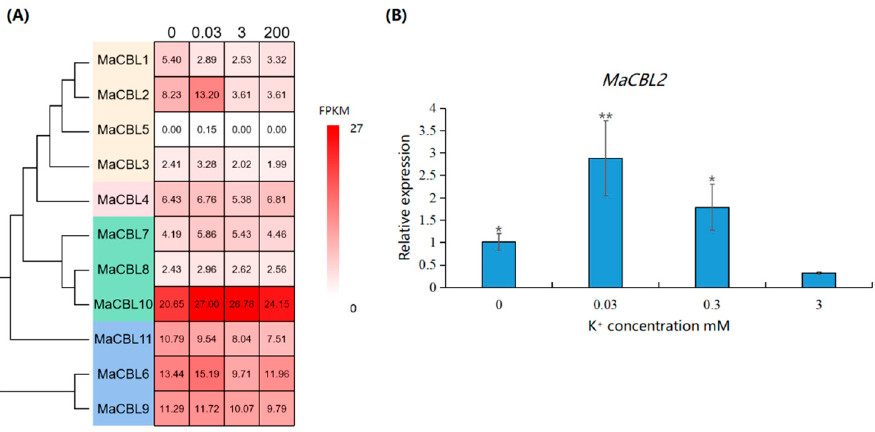
Figure 4. Expression tendency analysis of the MaCBL genes in bananas under potassium stress. ( A ) The expression pattern of MaCBLs in bananas under different potassium-stress levels, based on FPKM data. ( B ) The relative expression tendency of MaCBL2 as assessed by qRT-PCR. The asterisks indicate statistically significant difference, (*) for p ≤ 0.05, (**) for p ≤ 0.01.